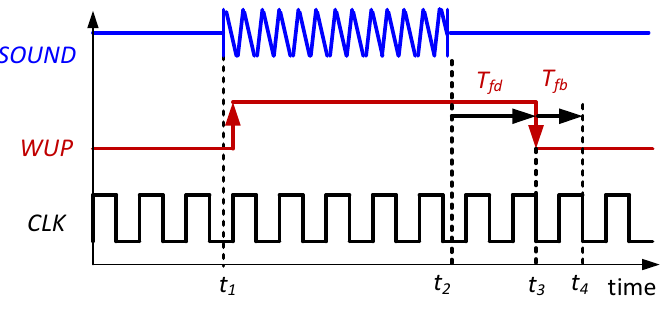
Figure 6. Architecture approach 5: After a predetermined delay time ( T fd ) elapses after the sound input disappears at t 2 , a falling edge at t 3 is expressed as a wakeup signal ( WUP ).